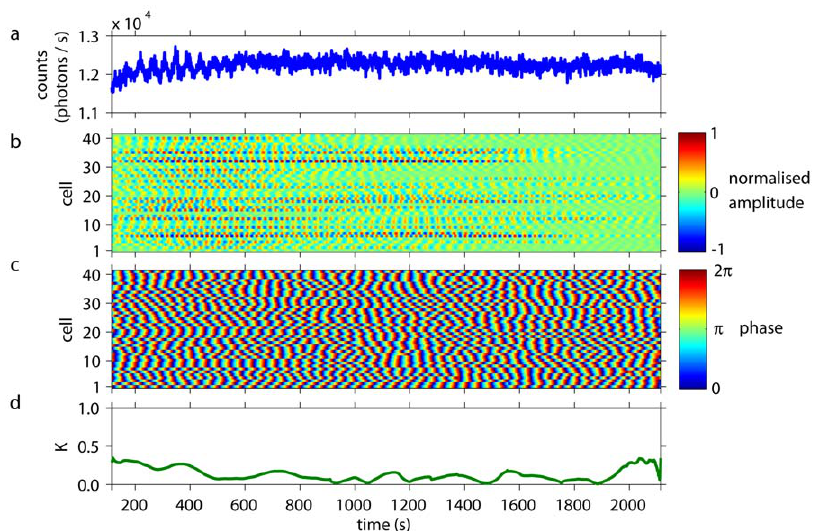
Figure 3. Collective and individual dynamics of S.carlsbergensis at a cell density of 0.01%. At t =0 an aliquot of 52 mM glucose was added to the starved and immobilised cells. (a) The time-series of the macroscopic, collective fluorescence signal is noisy but quiescent. Transient reminicences of oscillations can be spotted at 200 s ƒ t ƒ 400 s. (b) The individual cells remain oscillatory, even at this low cell density. The normalised oscillation amplitudes of the individual cells are decoherent. The amplitude of the oscillations of the cells corresponds to 120–200 photons/s.) Note, that the time spans where individual cells show pronounced oscillatory amplitudes vary considerably from cell to cell. The cells are numbered in a random order. (c) The plot of the phases of the oscillations shows that each cell oscillates, however, with its own phase and oscillation period. A slight and transient entrainment in the oscillation phases may be observed for some cells, giving rise to the reminicences of oscillations seen at collective signal at 200 s ƒ t ƒ 400 s. (d) The time-dependent Kuramoto order parameter K remains low at all times, indicating a complete desynchronisation among the oscillations of the individual cells.